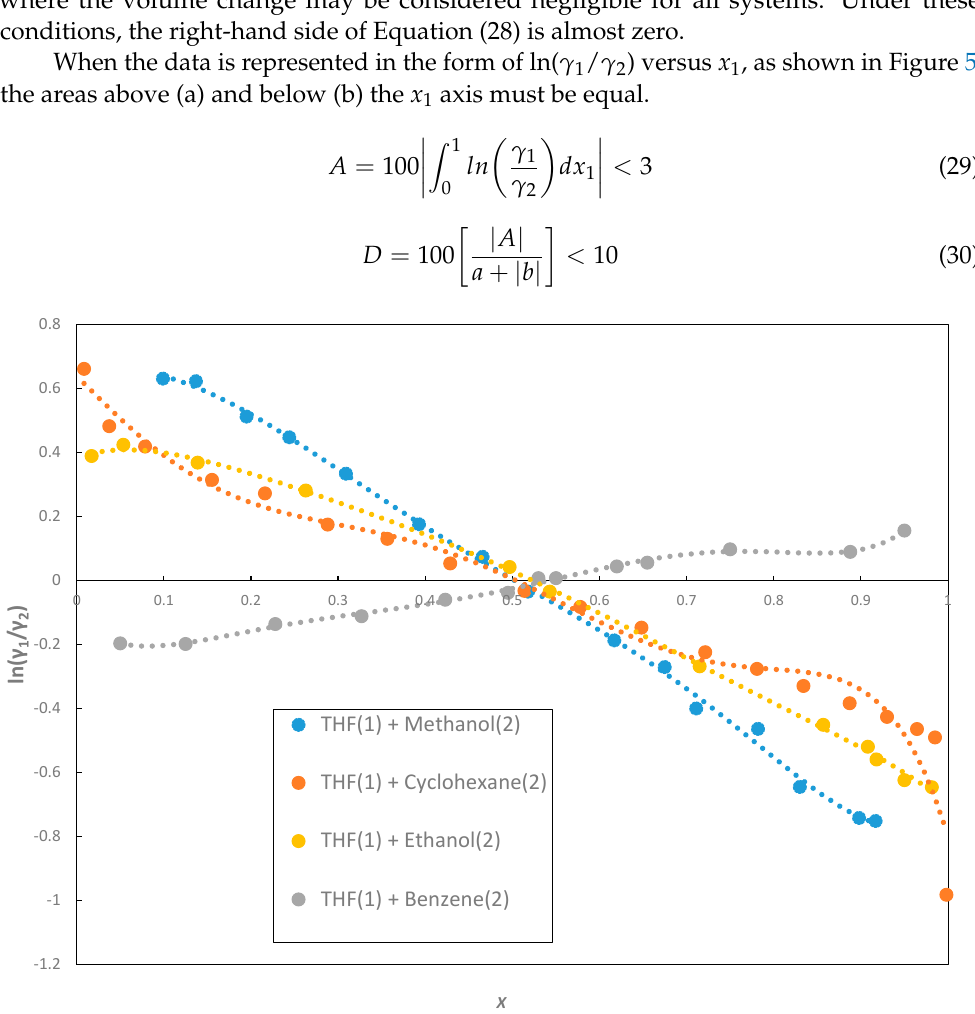
Figure 5. Herington test for isobaric and isothermal systems between THF(1)+ Methanol(2) at 103 kPa [12 ] , THF(1) + Cyclohexane(2) at 333.15 K [ 13 ] , THF(1) + Ethanol(2) at 100 kPa [14], and THF(1) + Benzene(2) at 303.15 K [ 15 ] .